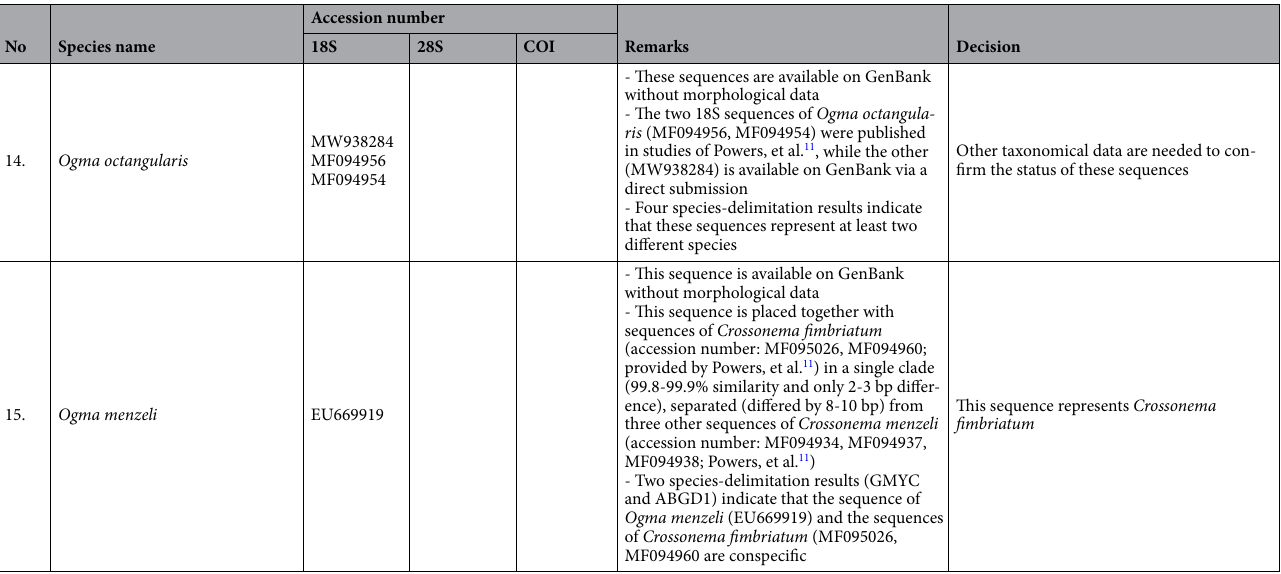
Table 4. Sequences in this study that were mislabeled, misidentified, or need